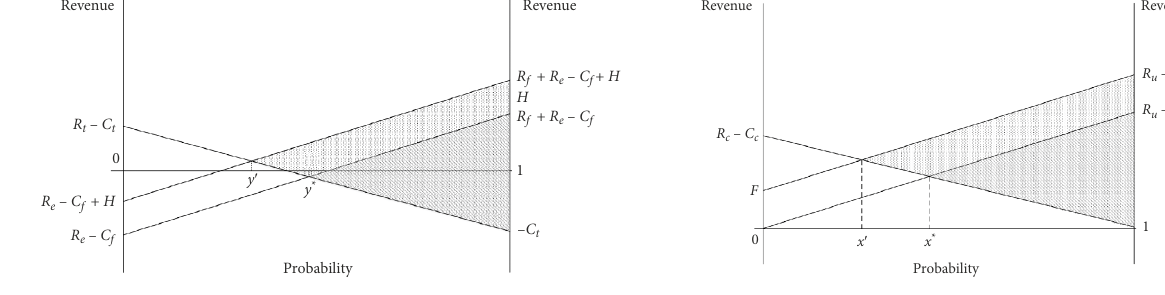
Figure 2. Developers’ revenue Figure 3. Customers’